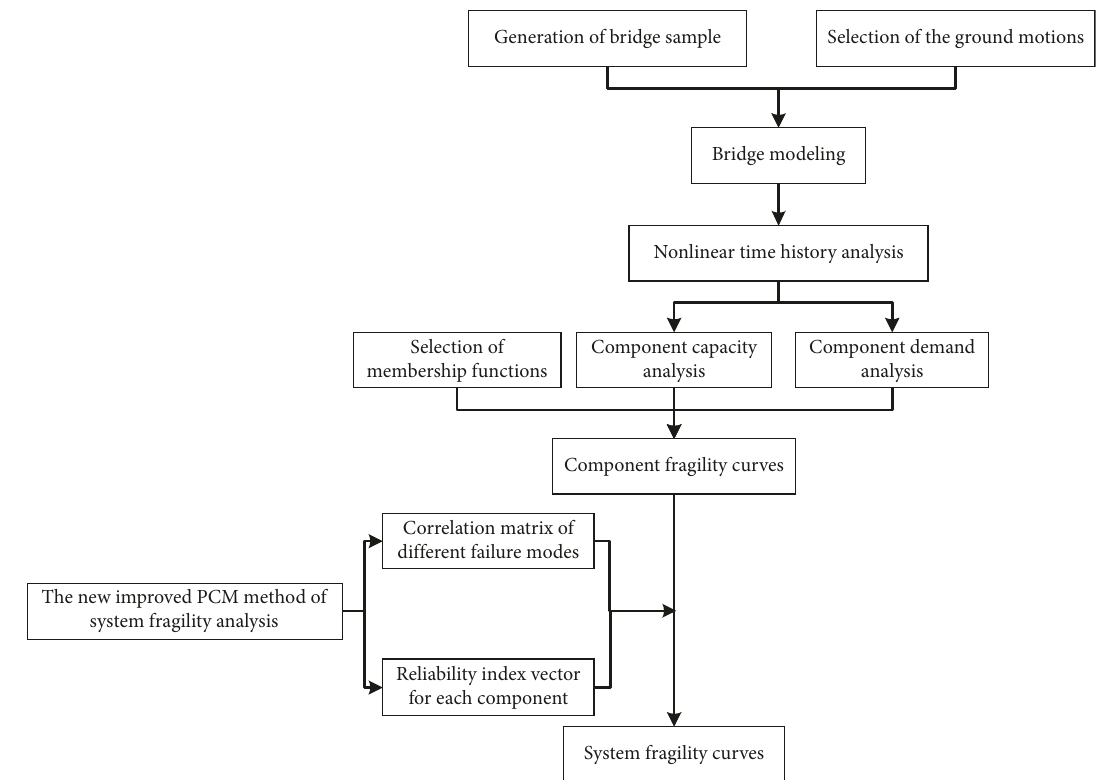
Figure 2: Flow chart of developing system fragility curves.